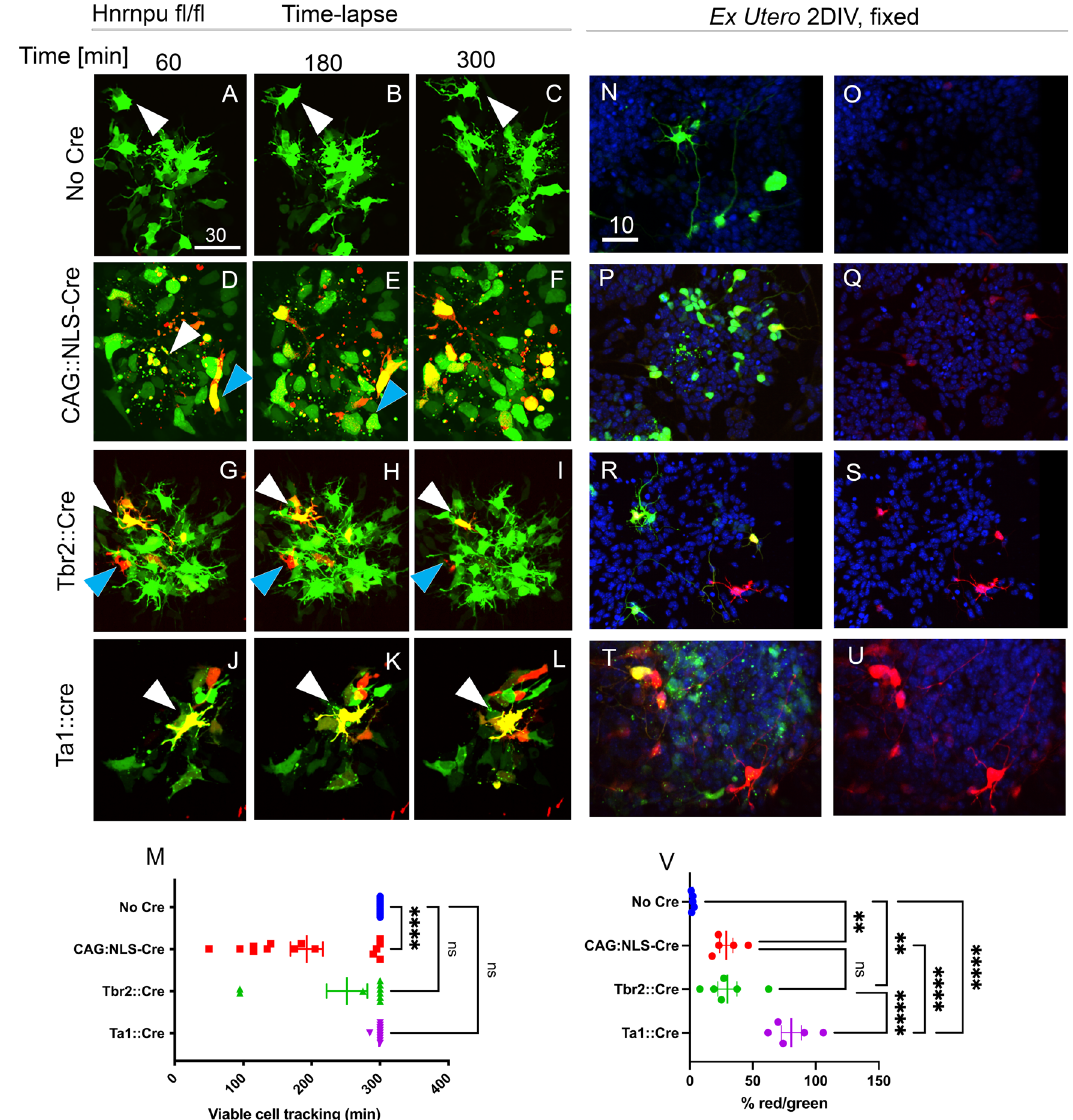
Fig. 2 Neural progenitors are highly sensitive to HNRNPU loss. Dual Color Cre reporter (CAG::SL) was electroporated to E13 Hnrnpu fl / fl embryos, injected with either no Cre ( A – C , N-0, Supp_Movie 1) or with Cre expressing plasmids under one of three promoters (CAG::NLS-Cre-GFP ( D – F , P , Q , Supp_Movie 2), Tbr2::Cre and ( G – I , R , S , Supp_Movie 3) Ta1::Cre ( J – L , T – U , Supp_Movie 4) A – L Images of time-lapse recording (5 h long) of primary cultures prepared from electroporated cortices. Arrowhead highlight speci fi c cells in the fi eld of view. M Tracking of cell viability in each fi eld of view, a dot indicates the last time point a tracked cell is visible before disintegration, vertical lines indicate average values, bars indicate ±SEM range. Statistical analysis was performed using one-way ANOVA with Dunnett ’ s multiple comparison tests, p < 0.0001. Control, n = 17, CAG::NLS-Cre-GFP n = 14, Tbr2::Cre, n = 9 and Ta1::Cre n = 10. N – U Images of fi xed primary cultures, after 2 days in vitro (2DIV), Showing transfected cells (expressing fl oxed ZsGreen, Green) and cells with an excised reporter (mCherry, Red). V Percentage of cells expressing mCherry out of ZsGreen expressing cells in